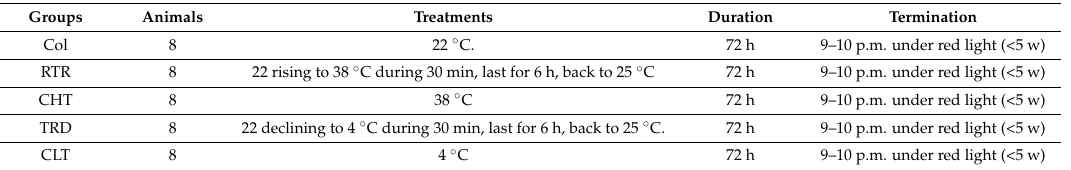
Table 2. Summarization of the animal study procedure for